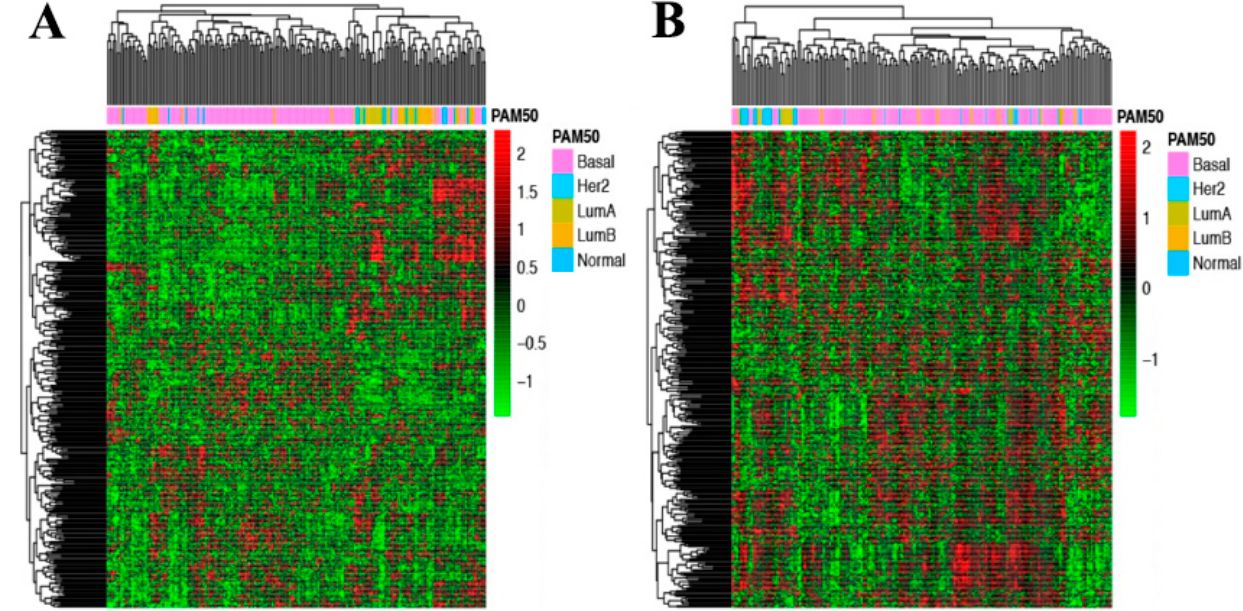
Figure 3. Unsupervised hierarchical clustering of TNBC using 345 glycogene expression. ( A ) Burstein’s dataset (N = 198). ( B ) TCGA dataset (N = 180). PAM50 molecular classification as shown in legend.